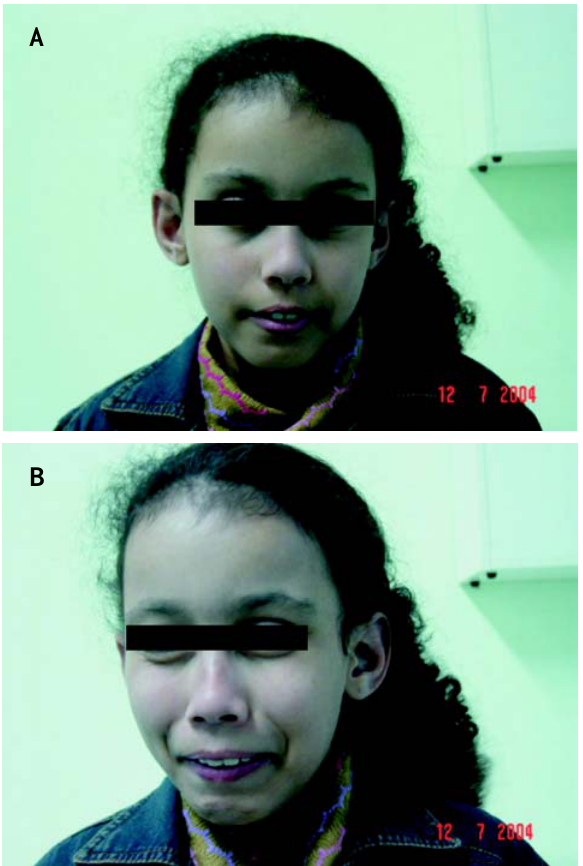
Figure 1 – Typical facial grimaces associated with Ochoa syn-